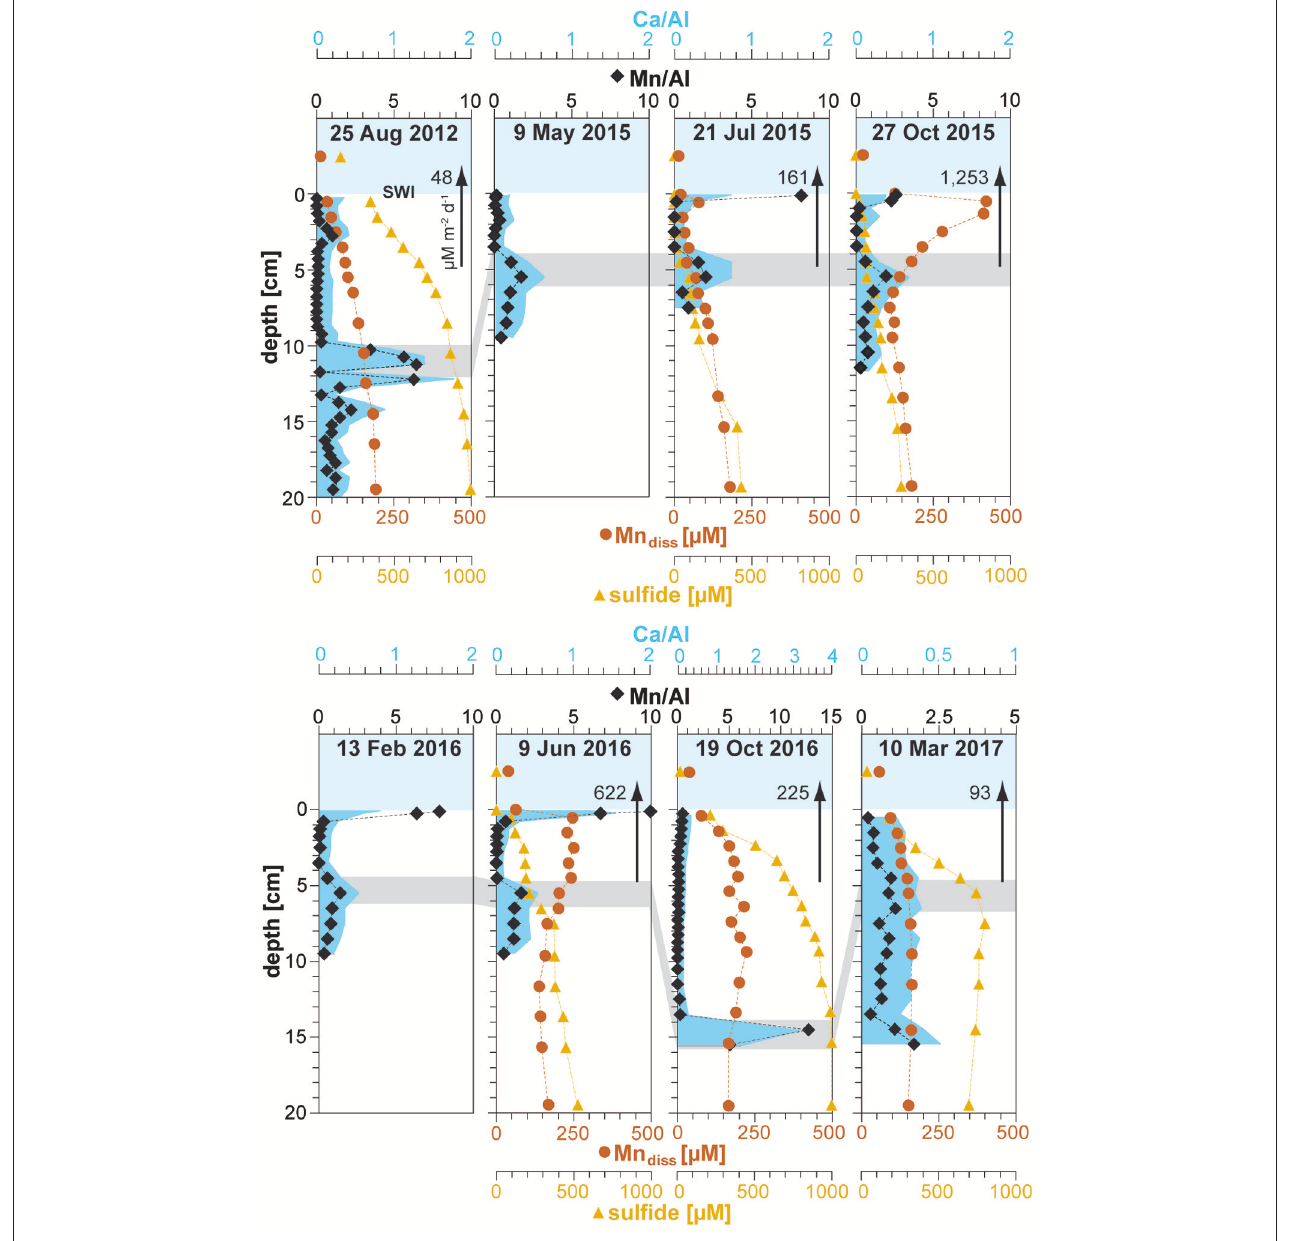
FIGURE 5 | Sedimentary Mn/Al and Ca/Al values, and Mn diss and total sulfide concentrations in pore waters from short cores obtained close to station 271 in the central Gotland Basin. Numbers next to the black arrows indicate pore water fluxes of Mn diss across the sediment-water interface (in µ M m − 2 d − 1 ). Gray bars indicate core parallelization based on Pb/Al ratios (Figure